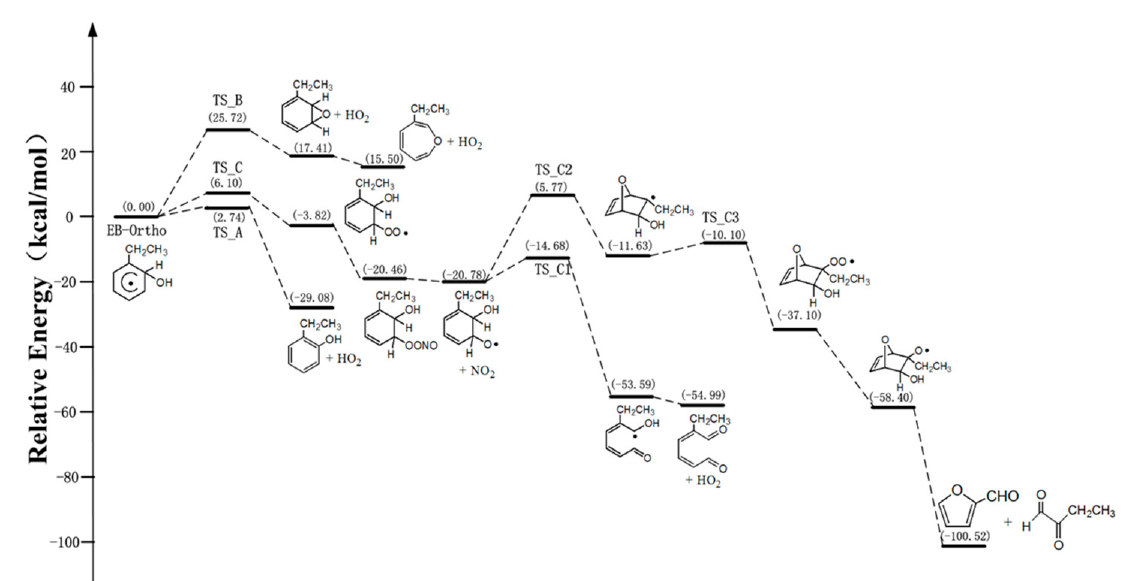
Figure 6. Potential energy surface at the CCSD(T)/6-311++G(d,p)//BHandHLYP/6-311++G(d,p) level of the EB-Ortho reaction with O 2 , as shown in Figure 1.